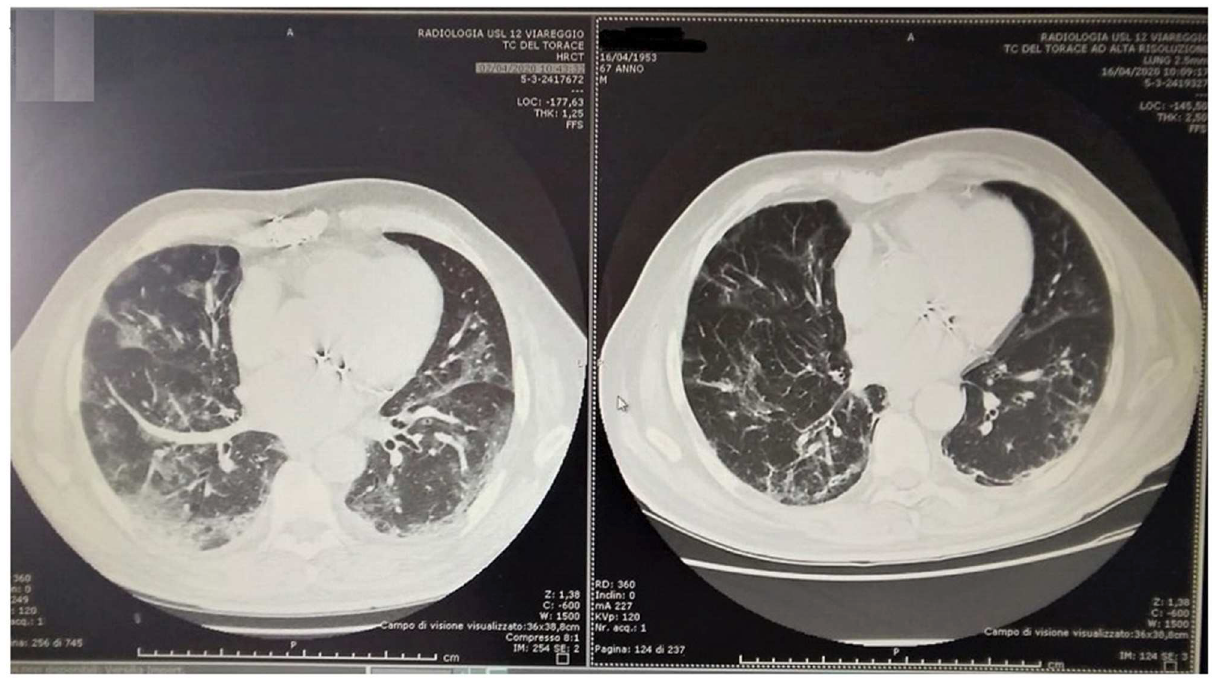
the mortality in Italian ICUs in a COVID-19 setting, similar to that we assessed (median age 63 years, male/female ratio 3:1, comorbidity numbers and baseline PaO 2 /FiO 2 with median